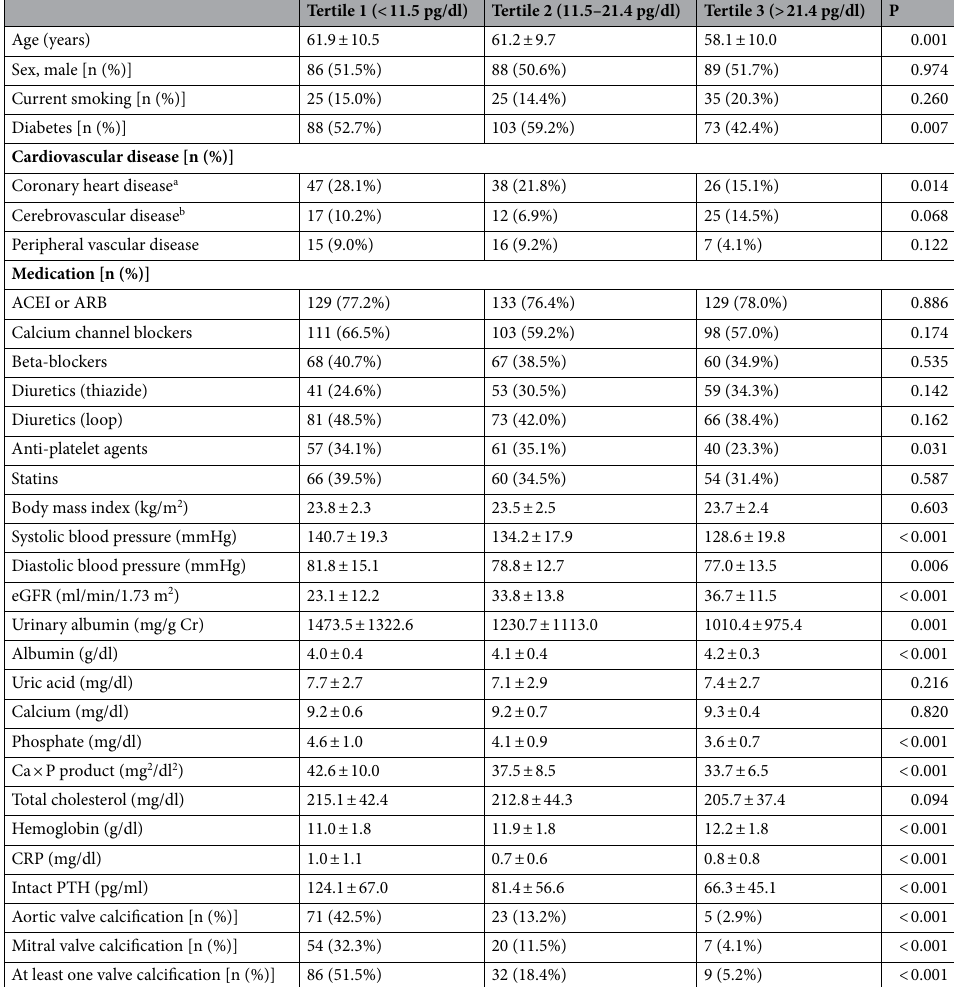
Table 1. Baseline characteristics of the study population according to tertiles of serum 1,25(OH) 2 D levels (n = 513). Data are presented as mean ± standard deviation or (n, %). a Coronary heart disease is defined as a history of coronary artery bypass surgery or percutaneous transluminal coronary angioplasty. b Cerebrovascular disease is defined as a history of stroke or transient ischemic attack. ACEI angiotensin-converting enzyme inhibitor, ARB angiotensin receptor blockers, Ca × P product, calcium × phosphorus product, CKD chronic kidney disease, CRP C-reactive protein, eGFR estimated glomerular filtration rate, PTH parathyroid hormone, 1,25(OH) 2 D 1,25-dihydroxyvitamin